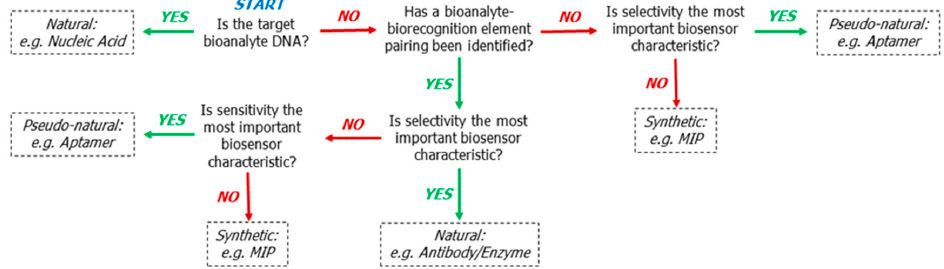
Figure 6. A flowchart for choosing a recognition element for biosensors, adopted from [77]. Reproduction permission granted by ACS Publishing.